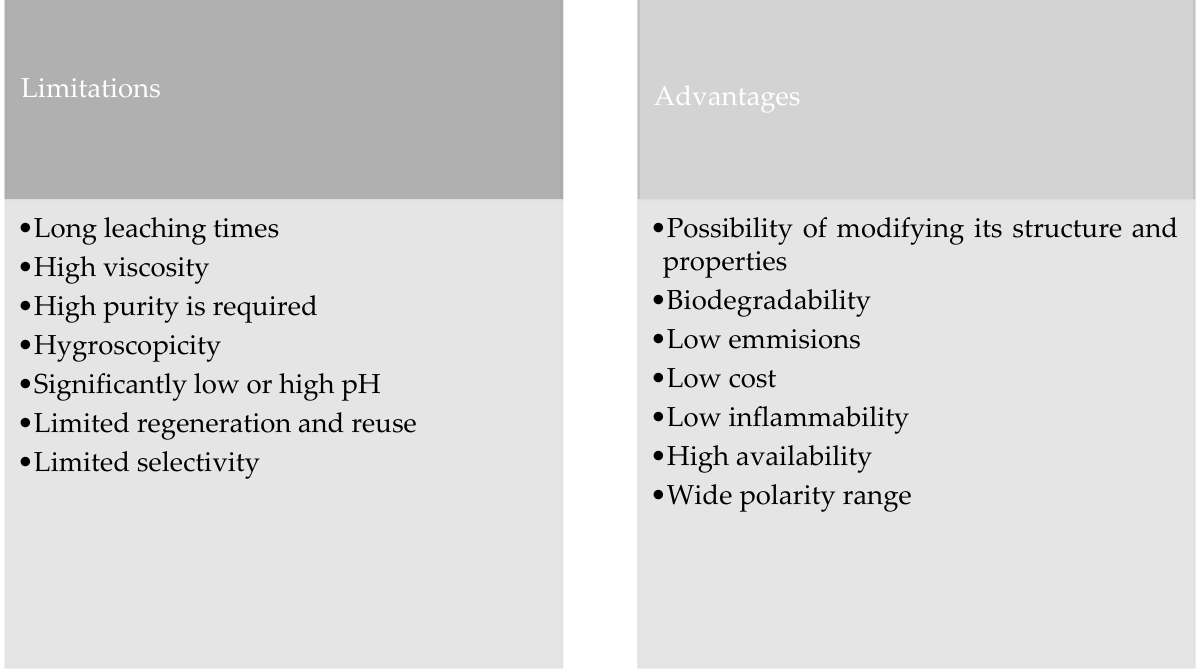
Figure 2. Limitations and advantages of the application of DESs in the solid–liquid and liquid–liquid processes.